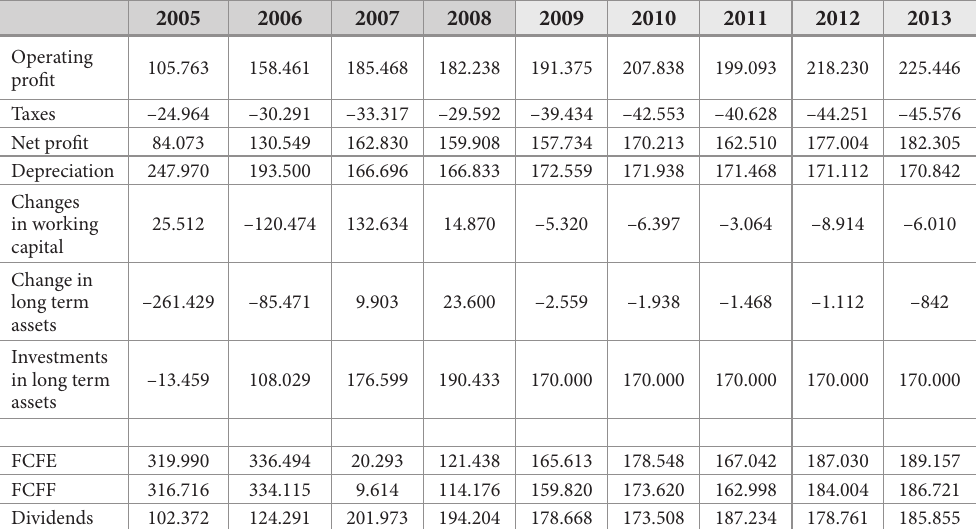
Table 9. Valuation results for TEO LT, AB, thousand